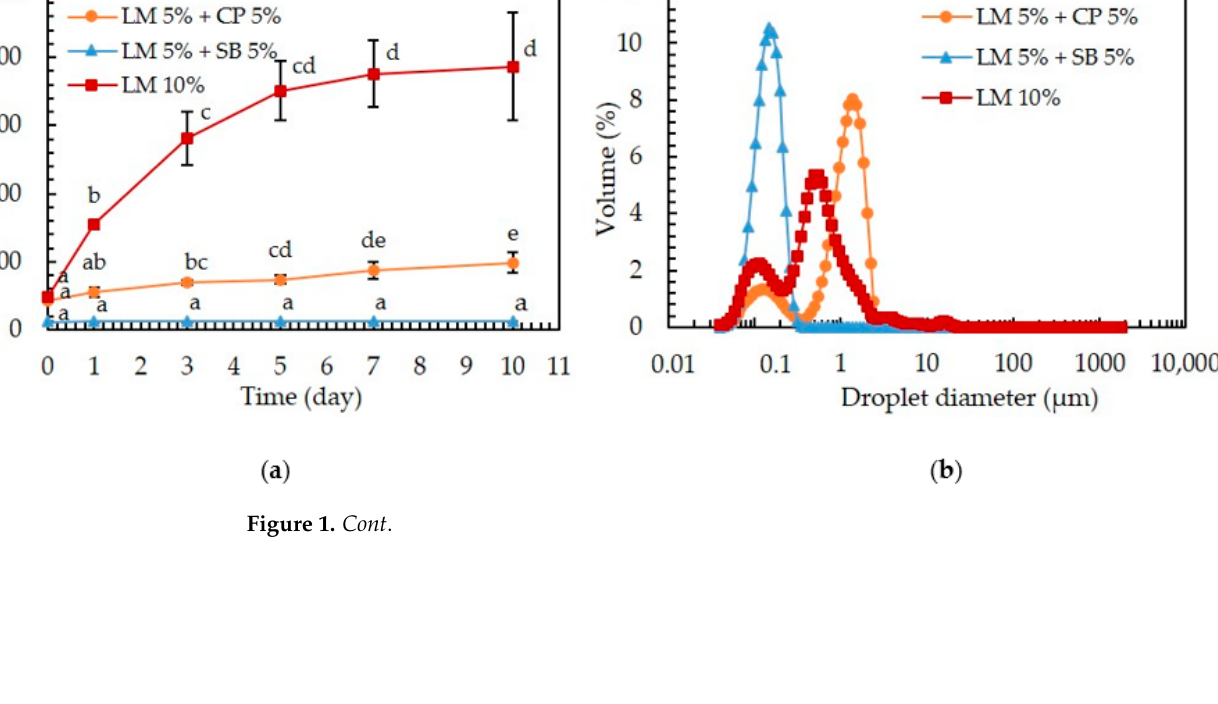
Figure 1. E ff ect of the dispersed phase in the D-limonene-loaded emulsions. ( a ) Storage stability at 25 °C ( b ) Droplet size distribution of freshly prepared emulsions, and ( c ) The photos of the emul- sions on days 0 and 10. The di ff erent le tt ers indicate signi fi cant di ff erences ( p < 0.05) by Duncan’s test. 3.2. E ff ect of SB Concentration on Disperse Phase and Emulsions Viscosity Gradually increasing SB concentration signi fi cantly increased the viscosity ( p < 0.05) of disperse phase since the viscosity of SB is high (47.35 mPa.s). However, despite utilizing varied concentrations in the disperse phase, it was found that after measuring the viscos- ity of freshly prepared emulsions, the viscosity was relatively low (1–2 mPa.s), which may be due to the use of a small amount of disperse phase (10% ( w / w )) in the emulsions. In addition, it is reported that the emulsions’ viscosity will increase when the droplets start to coalesce [25]. In this case, emulsions’ viscosity was measured immediately after emul- si fi cation, and therefore it showed stable viscosity. Furthermore, since the viscosity of dis- perse phase (LM:SB- 10:0; 0.79 mPa.s) was close to the continuous phase (1 mPa.s), and LM has a slight solubility in water (13.8 mg/L); thus, LM readily di ff uses in the water. Based on the Stokes-Einstein equation, it is found that di ff usivity is inversely proportional to viscosity. Hence, the reduced viscosity of the disperse phase enhances the di ff usivity of LM [23]. The instability of only LM-loaded and CP-assisted LM emulsions in Section 3.1 can also be explained by the phenomena of the lower viscosity of disperse phase.